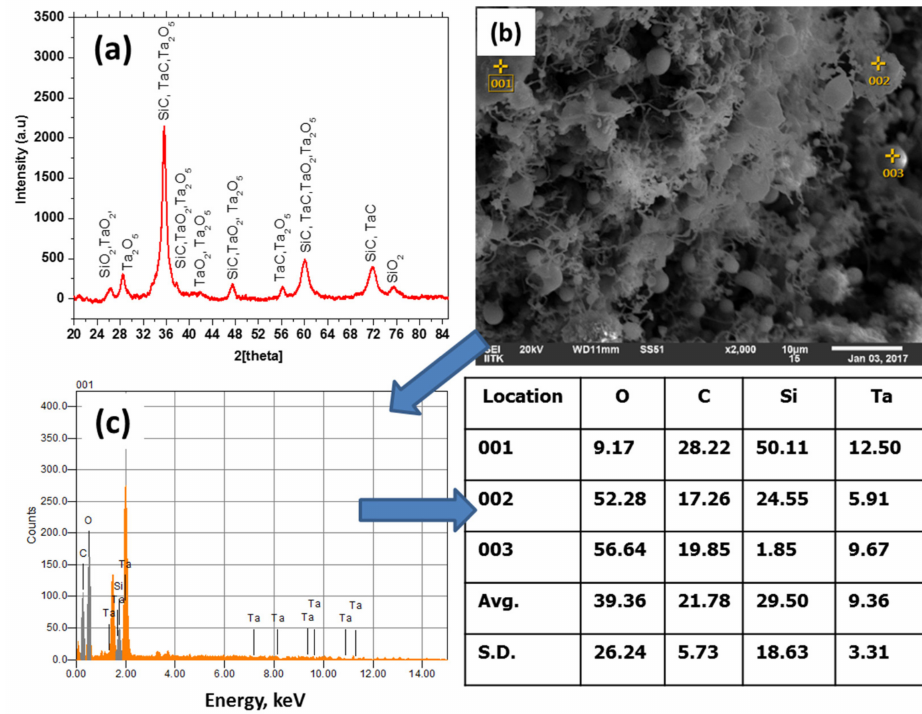
Figure 7. XRD and EDAX analysis of the ablated surface: ( a ) XRD spectra of the surface of the coating after the oxyacetylene test; ( b ) typical SEM image of the ablated surface; ( c ) EDAX spectra of the specific points at the ablated